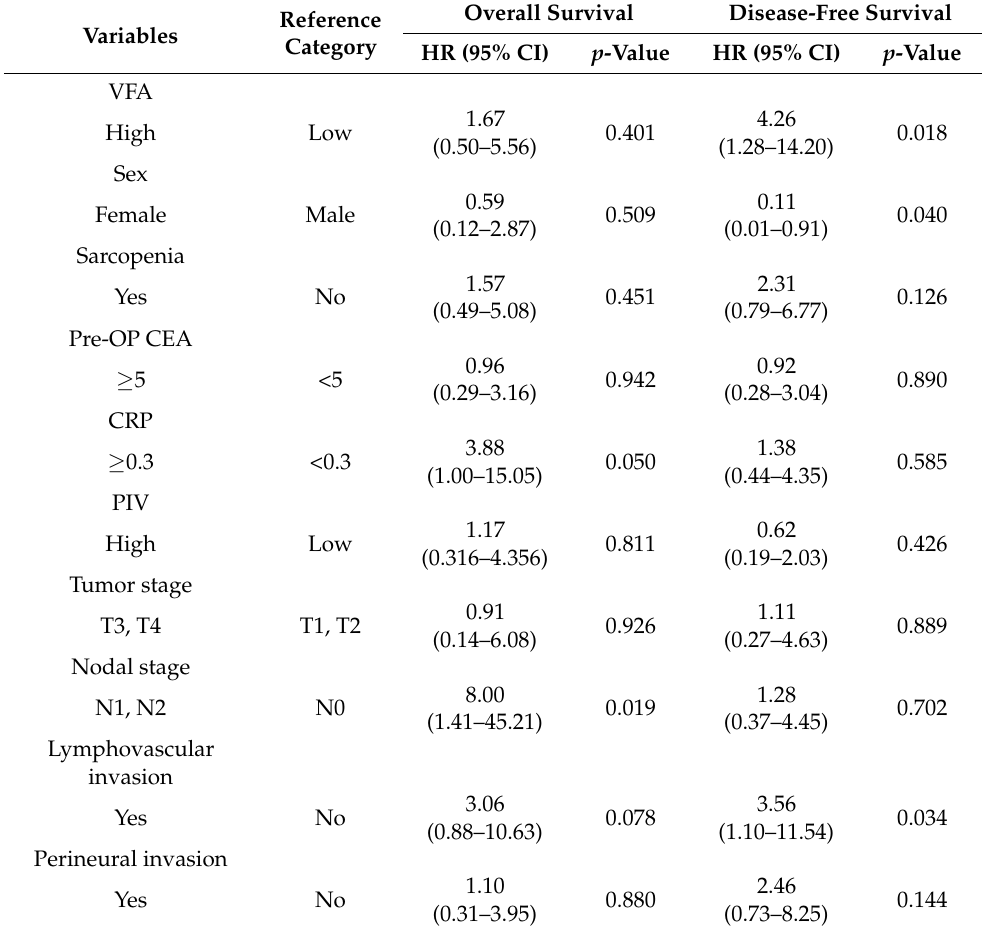
Table 7. Prognostic Factors of Overall Survival and Disease-Free Survival in Multivariate Analysis.